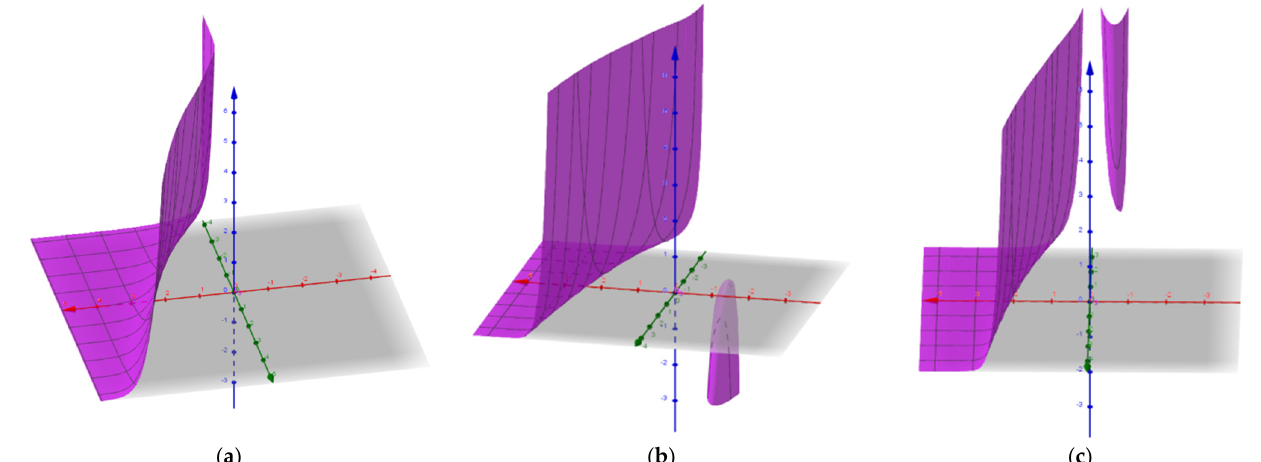
( , ) u x t , when ( ) = = = , the 3 1 2 3 = = ( ) ; and 4 m are given as above. 3 . .